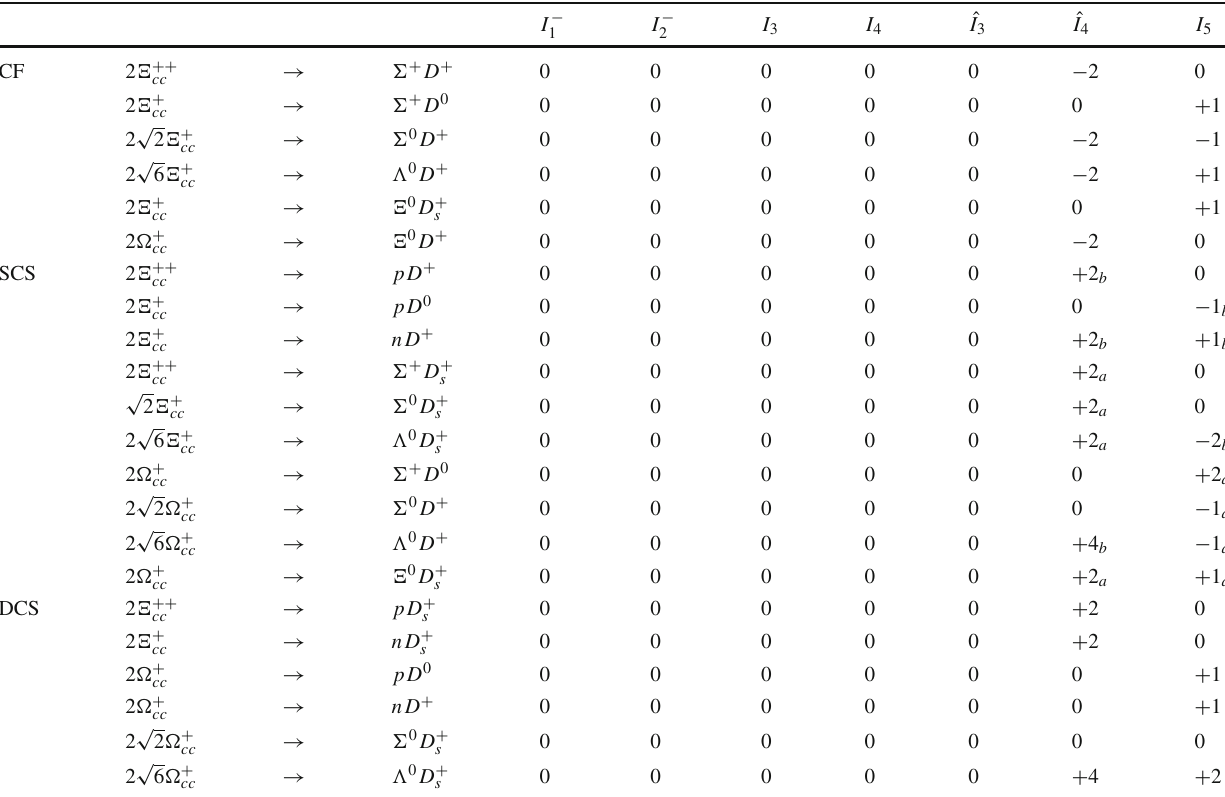
Table 12 Values of the seven topological tensor invariants for the non- leptonic CF, SCS and DCS decays B cc ( 3 ) → B ( 8 ) + M ( 3 ) of the triplet double charm baryon states (cid:6) ++ cc , (cid:6) + cc and (cid:10) + cc into the light